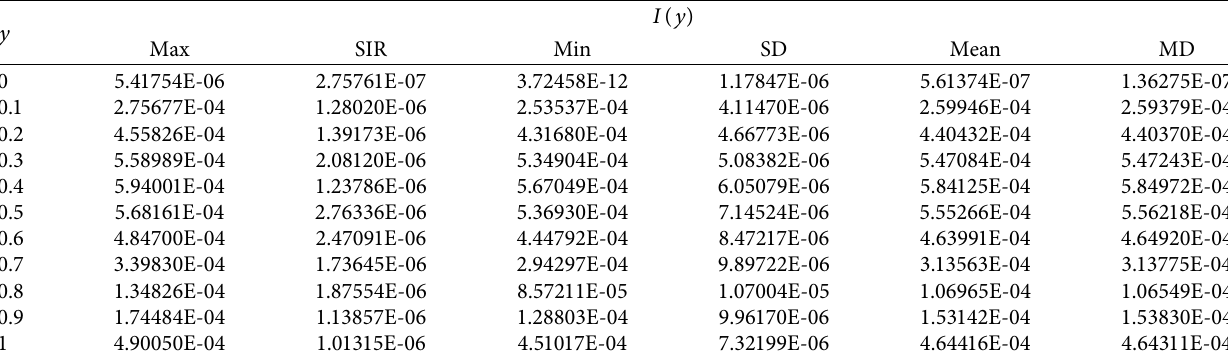
Table 4: Statistical performances for the class I ( y ) to solve the mathematical SEIR-NDC system.